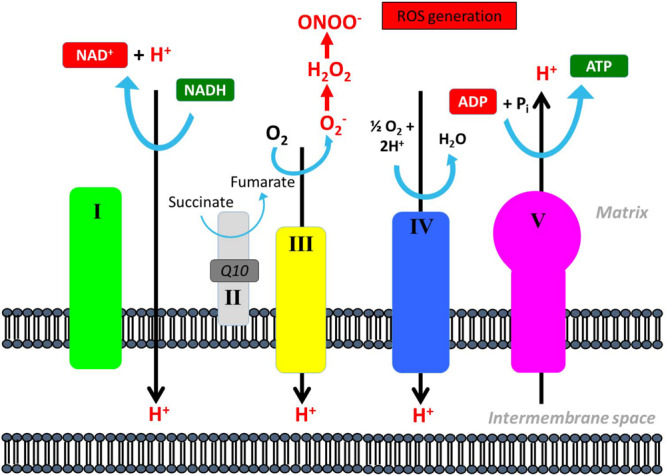
Reactive oxidative species production in the mitochondrial respiratory chain. Reactive oxidative species (ROS) can be generated through conversion of oxygen (O2) to superoxide anion (O2–) that can be converted further into peroxynitrite (ONOO–) that is a highly reactive species and can oxidize DNA, proteins, and lipids and interfere with important vascular signaling pathways.